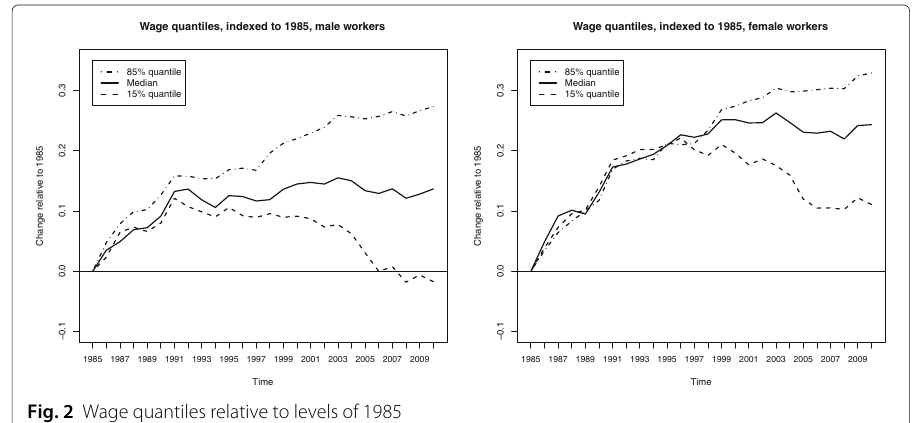
Fig. 2 Wage quantiles relative to levels of 1985 Petrongolo 2008; Edin and Gustavsson 2008; Schmieder et al. 2010; Edler et al. 2015; Paul 2016; Blundell et al. 2016). Returns to labor market experience are not uniform across jobs and type of work. Not only is experience in part-time work valued lower than that in full- time work, but part-time and nonemployment episodes slow down career progression and wage growth (see literature review in Section